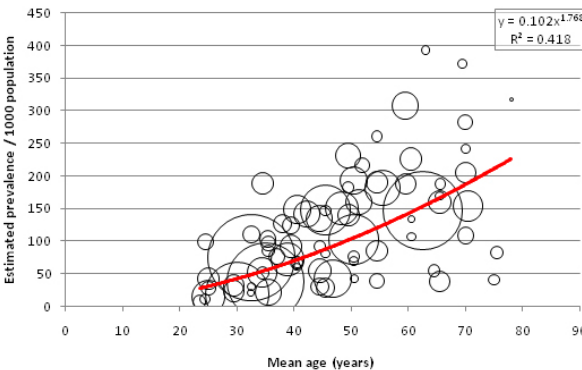
100.00 OGTT–only population prevalence: 6.95% Overall population prevalence (2005):